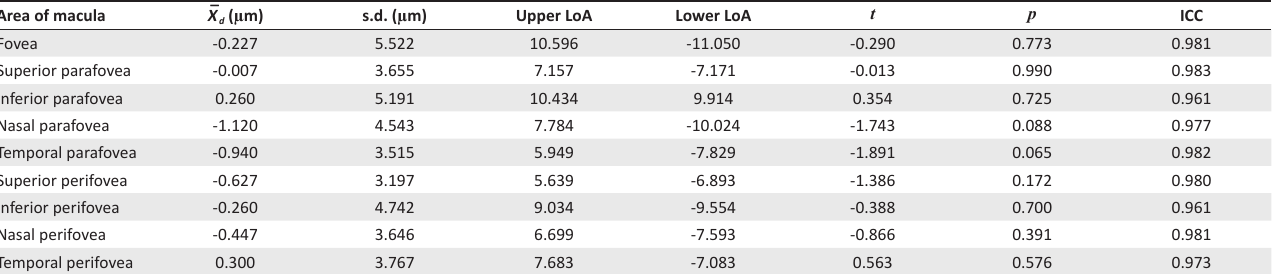
TABLE 2: The mean differences ( X‾ d ), and their standard deviations for macular thickness ( µ m) between observers, Bland-Altman upper and lower limits of agreement, t - and p -values from paired t -tests and the intra-class correlation coefficients. Area of macula